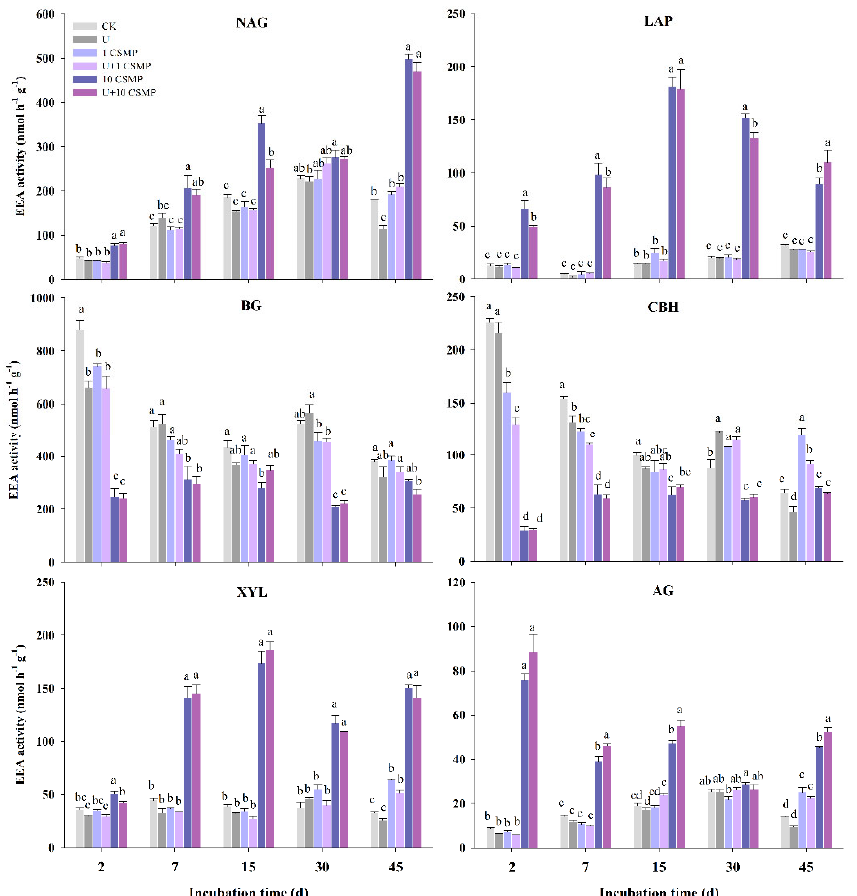
Figure 4. Soil extracellular enzyme activities (EEAs) as affected by the amendment during the incubation. CK, no mineral amendments or urea; U, urea at 60 mg N kg − 1 soil; 1 CSMP, 1 g CSMP kg − 1 soil; U+1 CSMP, urea at 60 mg N kg − 1 + 1 g CSMP kg − 1 soil; 10 CSMP, 10 g CSMP kg − 1 soil; U+10 CSMP, 60 mg N kg − 1 + 10 g CSMP kg − 1 soil. NAG, β − 1,4 − N − acetylglucosaminidase; LAP, leucine aminopeptidase; BG, β − 1,4 − glucosidase; CBH, β − D − cellobiosidase; AG, α − 1,4 − glucosidase; XYL, β − xylosidase. Error bars represent standard error of the mean (n = 3). Different lowercases indicate significant differences among treatments ( p < 0.05).